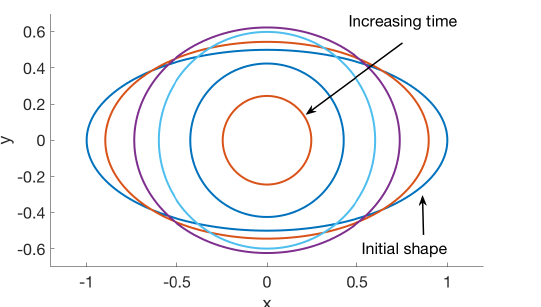
Figure 5. Numerical solution of example 3 for the blob ψ δ ( r ) in Table 1 using permeability parameter α = 0.01, regularization parameter δ = 0.06, N = 400, and µ = 1. The initial membrane shape was the ellipse of major axis 1 and minor axis 1/2. The figure shows the computed solution at times t = 0,0.5,2,7,16,22.